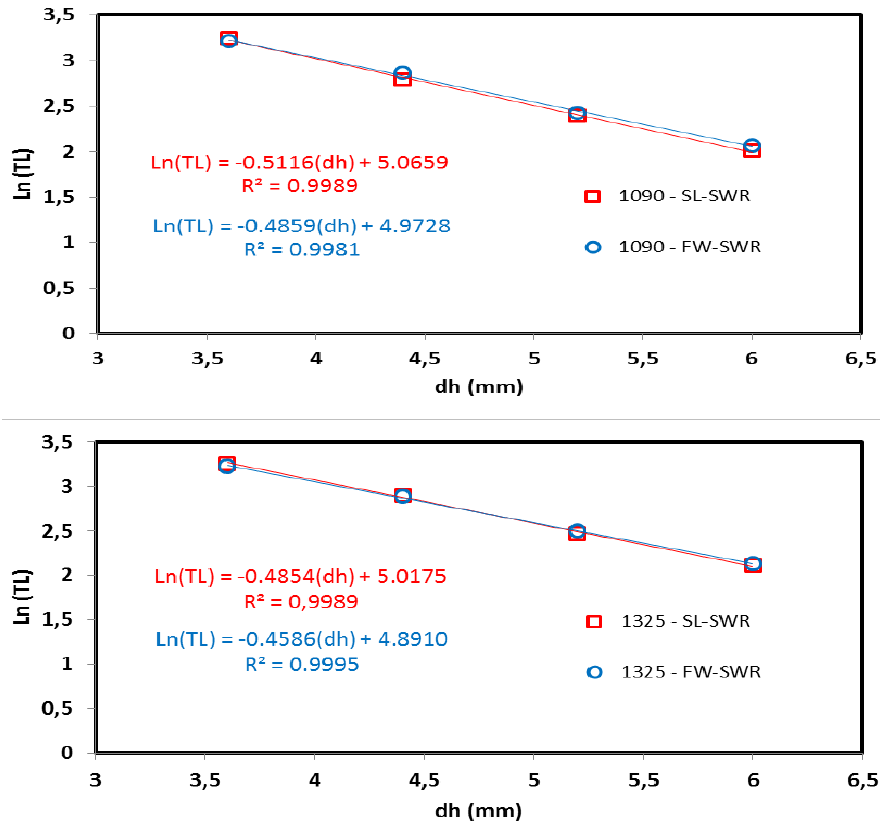
Figure 6. Steady-state to steady-state toe length data against the head difference dh in seawater retreat (SWR) experiment in case 1090 ( top ) and case 1325 ( bottom ) for both FW and SL scenarios.